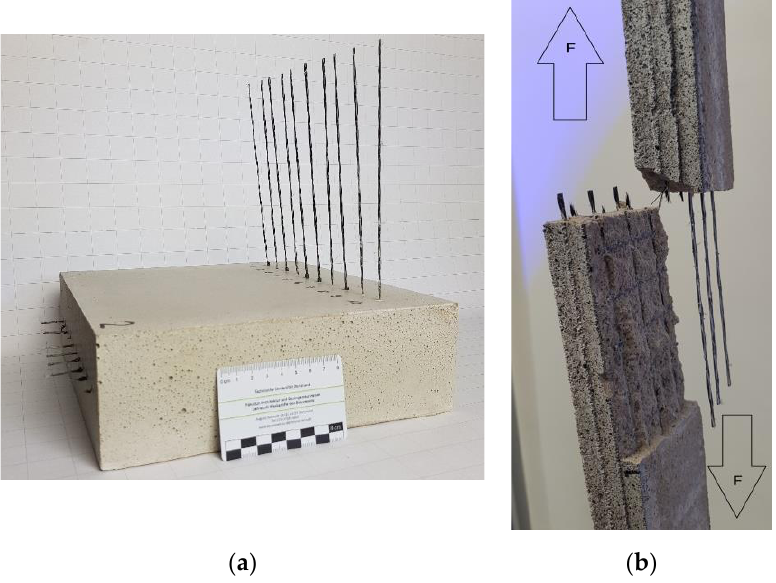
Figure 6. ( a ) A bent-strand tensile test specimen, ( b ) a sample with the textile overlapping after the central tension test (© Jan Überschär).